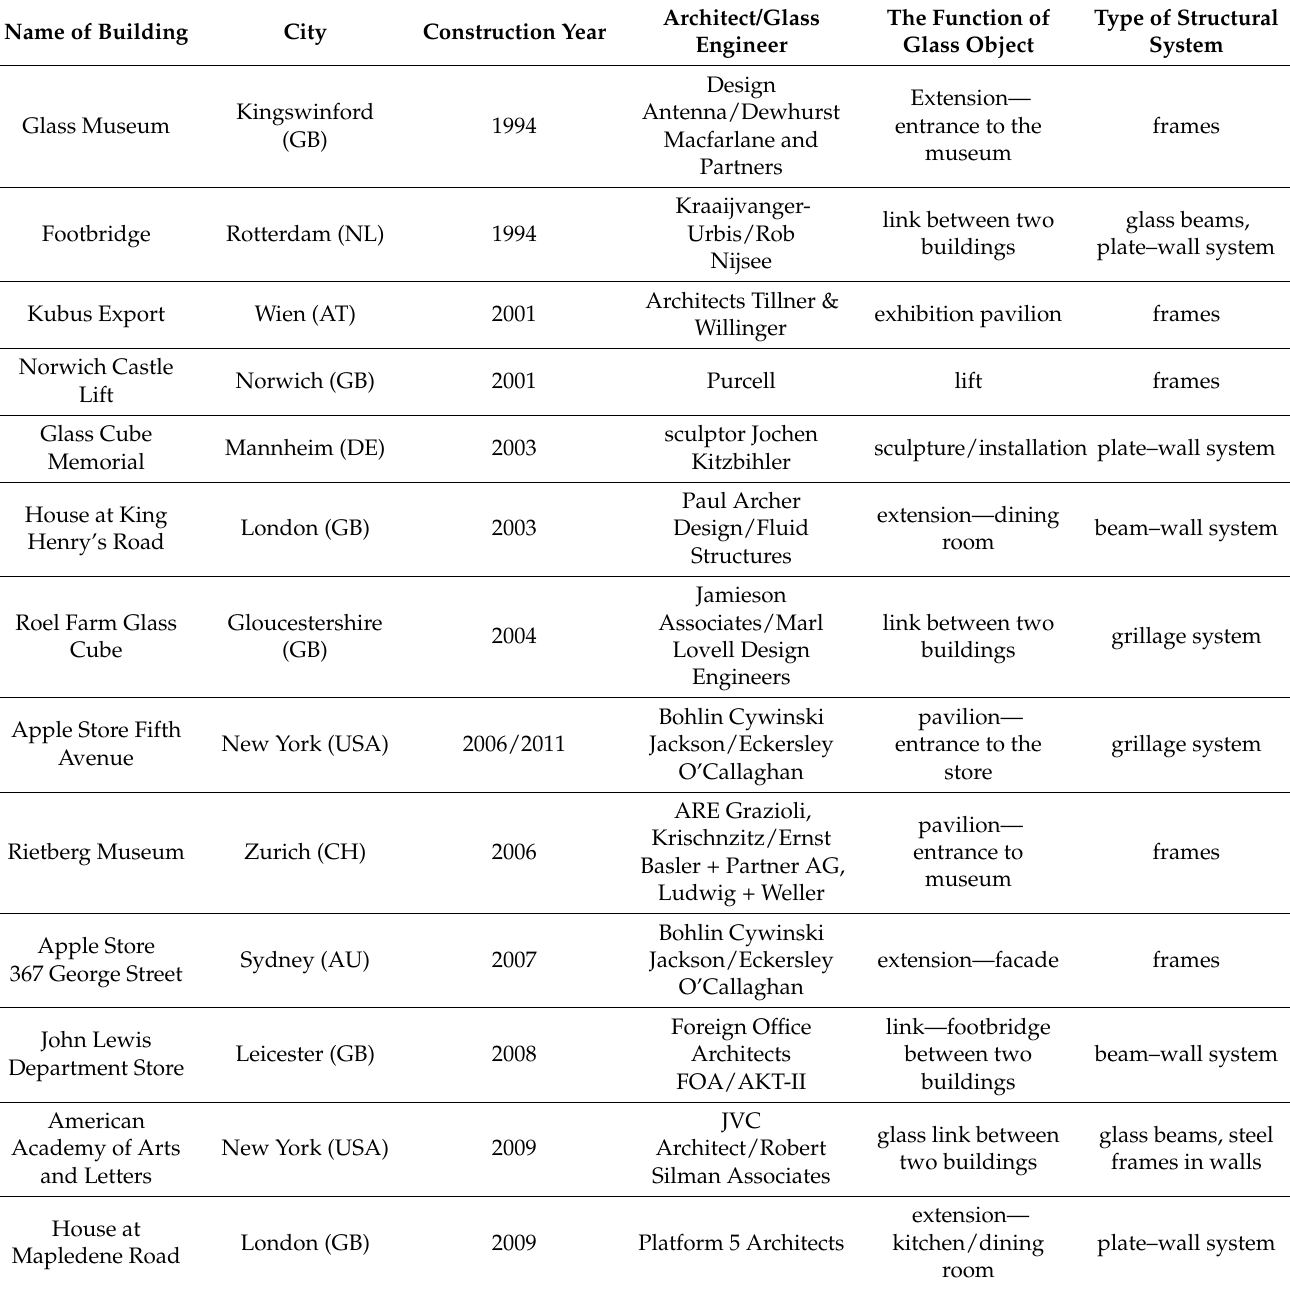
Table 1. Chronological list of analysed all-glass